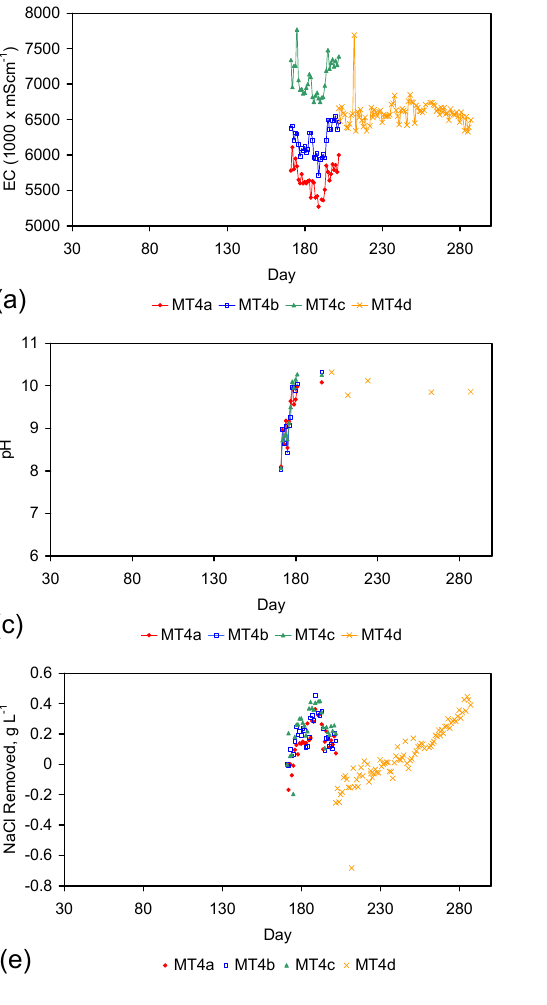
Figure C16. ( a ) EC vs. day; ( b ) Eh vs. day; ( c ) pH vs. day; ( d ) pH vs. Eh; ( e ) NaCl Removed (calculated from EC and residual water volume) vs. day. MT4a = 91.3 g·L − 1 ; MT4b = 87.8 g·L − 1 ; MT4c = 91.3 g·L − 1 ; MT4d = 90.1 g·L − 1 . Reactor Size (MT4a–MT4c): 2.3 L; Feed Water volume: 2.3 L. Reactor Size (MT4d): 10 L; Feed Water volume: 6.9